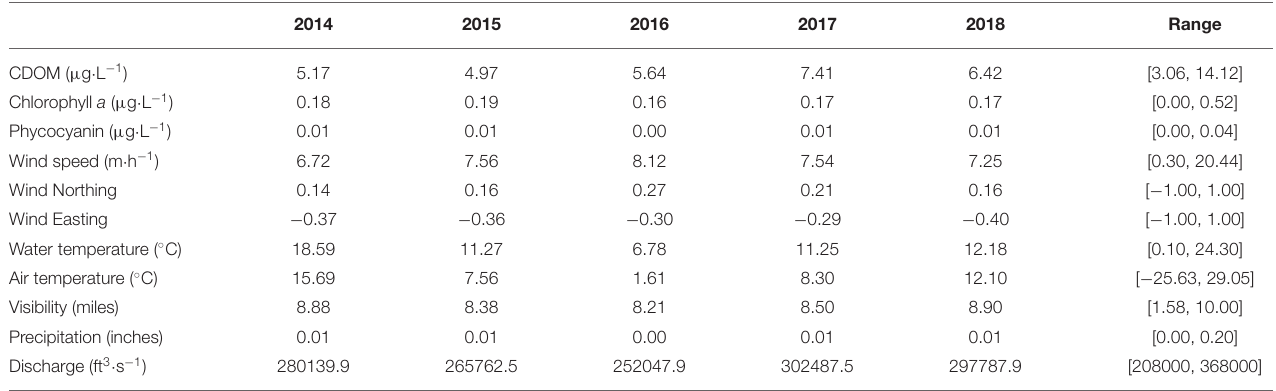
TABLE 1 | Table of daily averages and ranges of the quantitative variables considered.